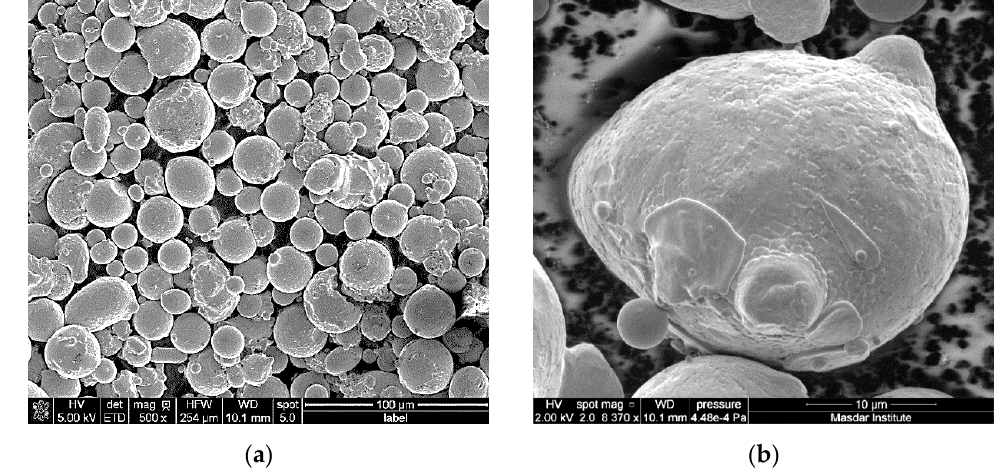
Figure 1. ( a ) The as-received gas atomized IN718 powder showing the range of powder sizes; ( b ) magnified particle showing attached satellites.